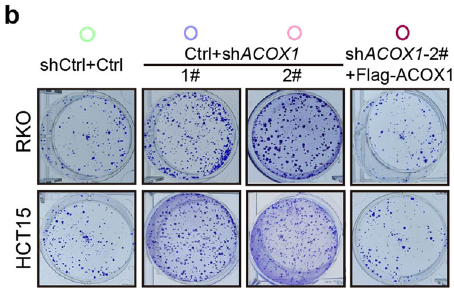
“ Supplementary Fig. S9e ” . The correct fi gure legends are as below. Fig. 2a Enhanced CRC cell viability by ACOX1 depletion. Cell viability of ACOX1 -depleted CRC cells (HCT116, RKO, SW620, HCT8, and HCT15) was analyzed for CCK-8. Fig. 3h DUSP14 mediates ubiquitination of ACOX1 at K643. Myc-Ub was co-transfected with HA-DUSP14 and Flag-ACOX1 (WT, K29R, K241R, K255/260R, K446R, or K643R) into HEK293T cells, and the cell lysates were subjected to